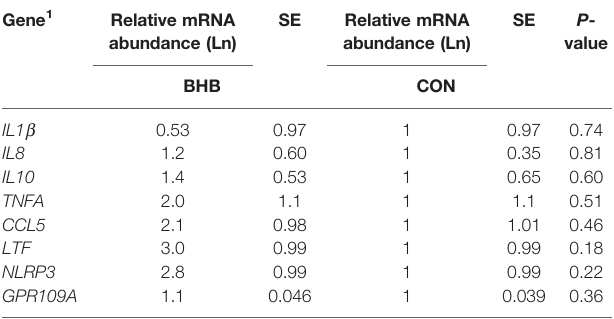
TABLE 2 | Transcript abundance from mammary tissue collected from S. uberis right rear challenged quarter of late lactation cows that were either infused with saline (n = 6) or BHB (n = 6) to maintain a 1.8 mM concentration for 72 h.